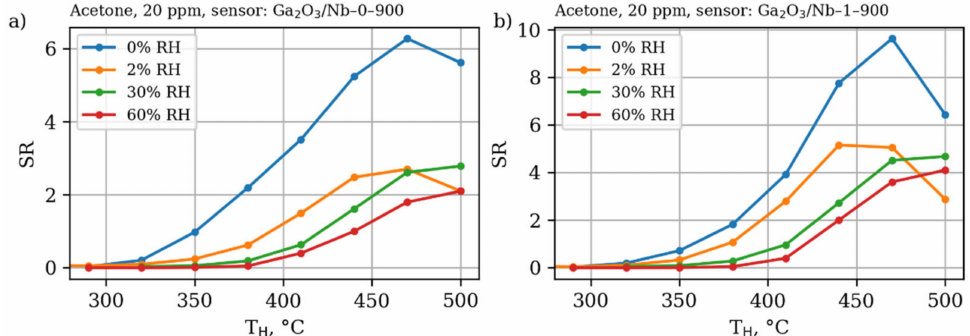
Figure 11. Dependence of sensor response of ( a ) pure Ga 2 O 3 -based materials annealed at 900 ◦ C and ( b ) 1% mol Nb-doped Ga 2 O 3 -based materials annealed at 900 ◦ C at different working temperatures towards acetone 20 ppm in dry air and in air with relative humidity (RH) 2%, 30% and